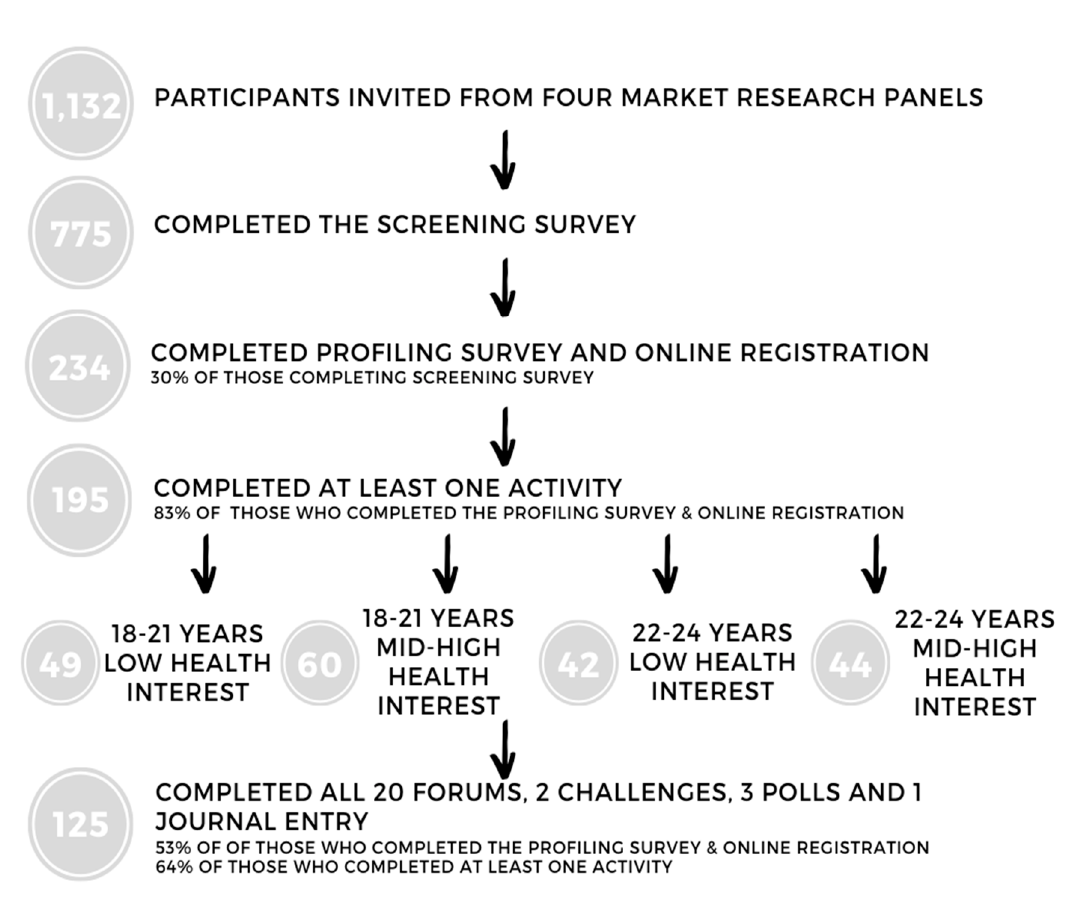
Figure 2. Online Conversations Participant flow chart.